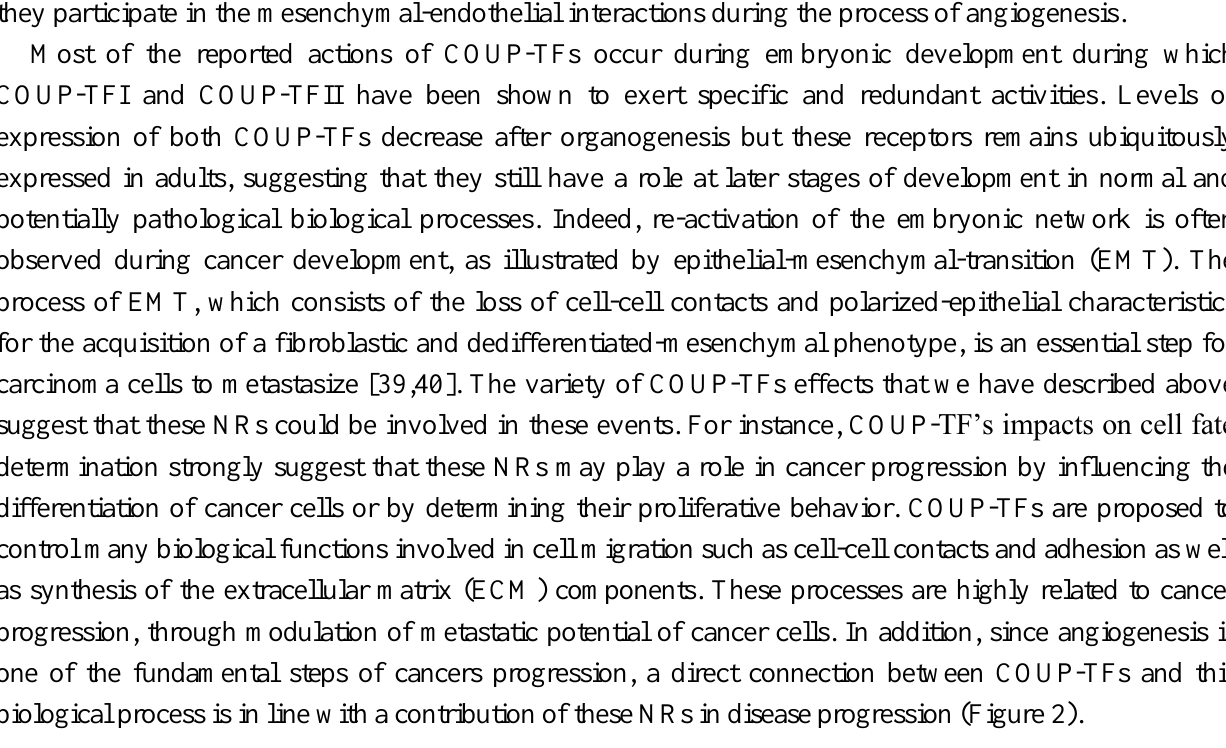
Figure 2. Principal biological processes controlled by COUP-TFs during